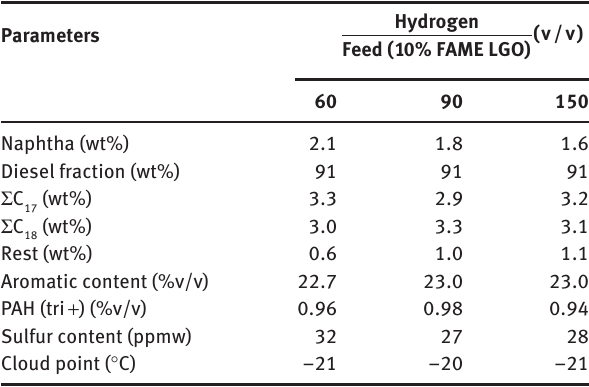
Table 4: Physicochemical properties of 10% fatty acid methyl ester (FAME) + light gas oil (LGO) product obtained by hydrodesulfuriza- tion (HDS) on Ni-Mo catalyst for different H space velocity (LHSV) = 1 1/h and T = 360 °